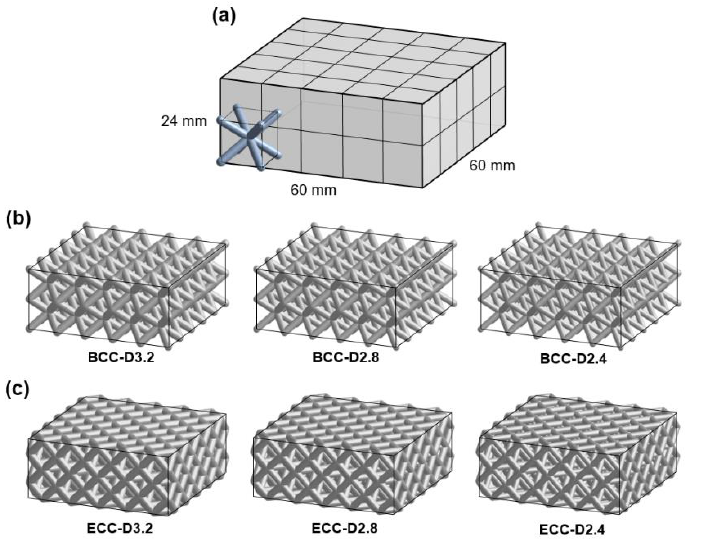
Figure 2. ( a ) Definition for the block of lattice core sample, and the lattice core samples constructed from ( b ) BCC unit cells and ( c ) ECC unit cells. Table 1. The porosity of the six cubic based lattice structures.